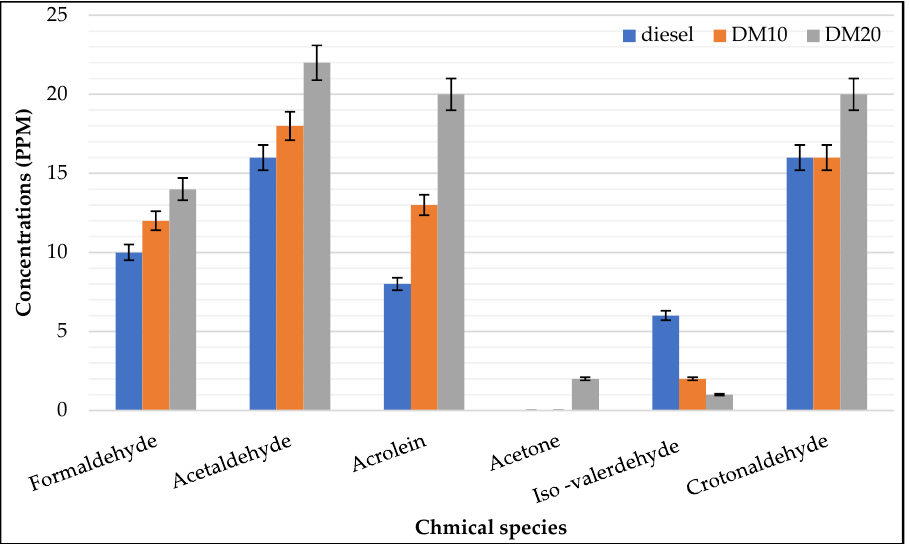
Figure 7. Emissions concentration with carbonyl compounds speciation (6 bar NMEP).